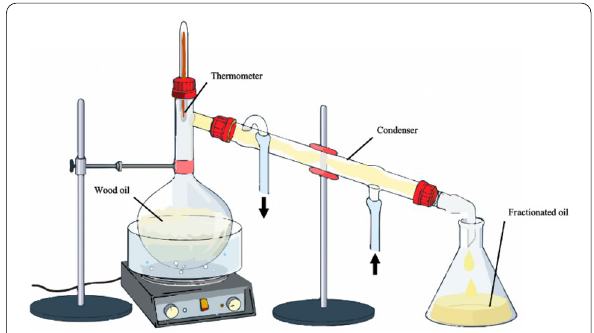
Fig. 1 Schematic illustration for the fractional distillation of essential oil